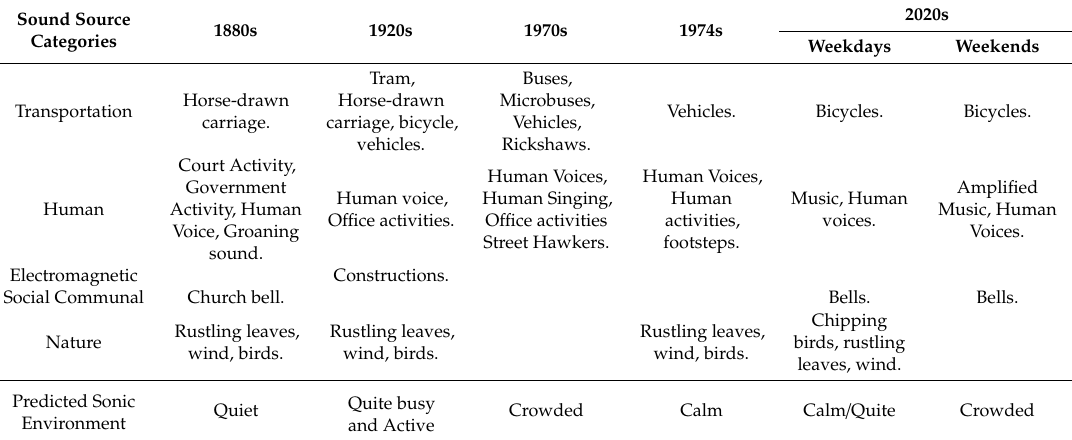
Table 1. The classification of sound sources in Fatahillah Square over the